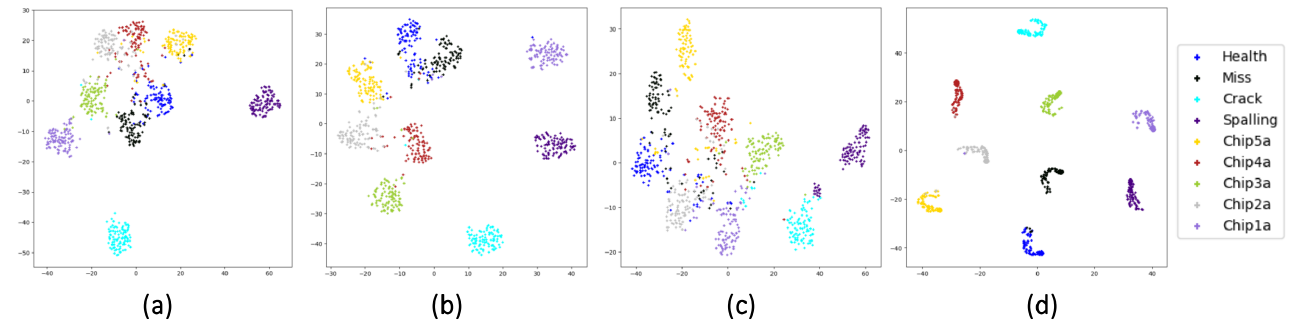
Figure 11. Feature maps visualization for UoC with noise and trend items: ( a ) visualization of FD- stream before the first fusion, ( b ) visualization of TFD-stream before the first fusion, ( c ) visualization of TD-stream before the first fusion, and ( d ) visualization after the second fusion.